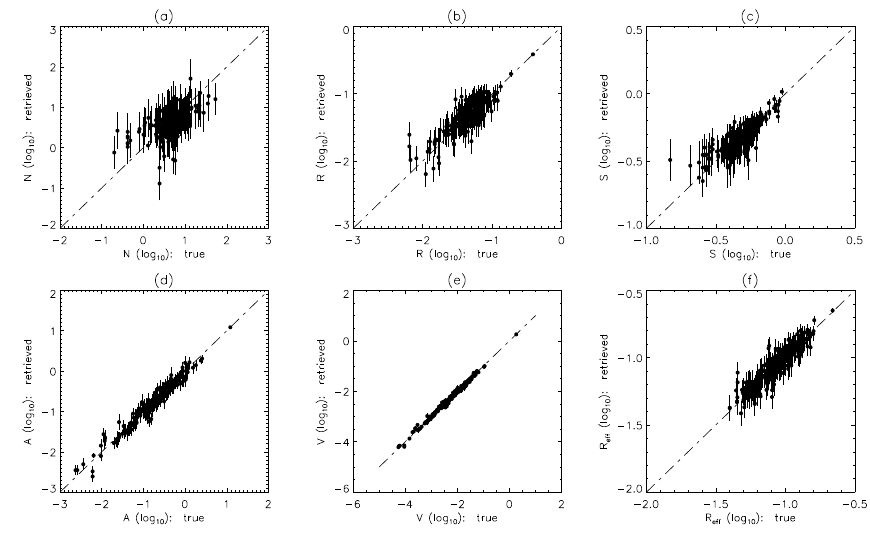
Fig. 3. Minimum Noise Scenario: True versus retrieved values of (a) particle number density N , (b) median radius R , (c) distribution width S , and (d) associated surface area density A , (e) volume density V , and (f) effective radius R eff , with their respective uncertainties. All values are given in log 10 . The broken line marks where the retrieved and true values are identical.